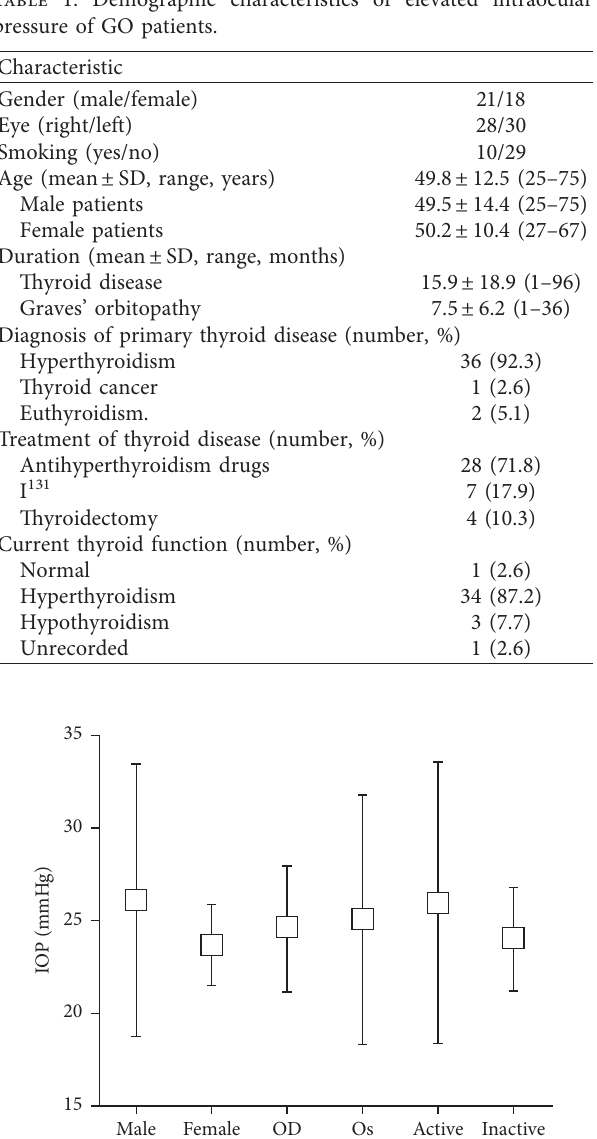
Figure 1: Box and whisker plot showing the distribution of in- traocular pressure (IOP) for different genders, eyes, and disease activity grades. No significant difference in IOP was found between genders, eyes, and disease activity grades.